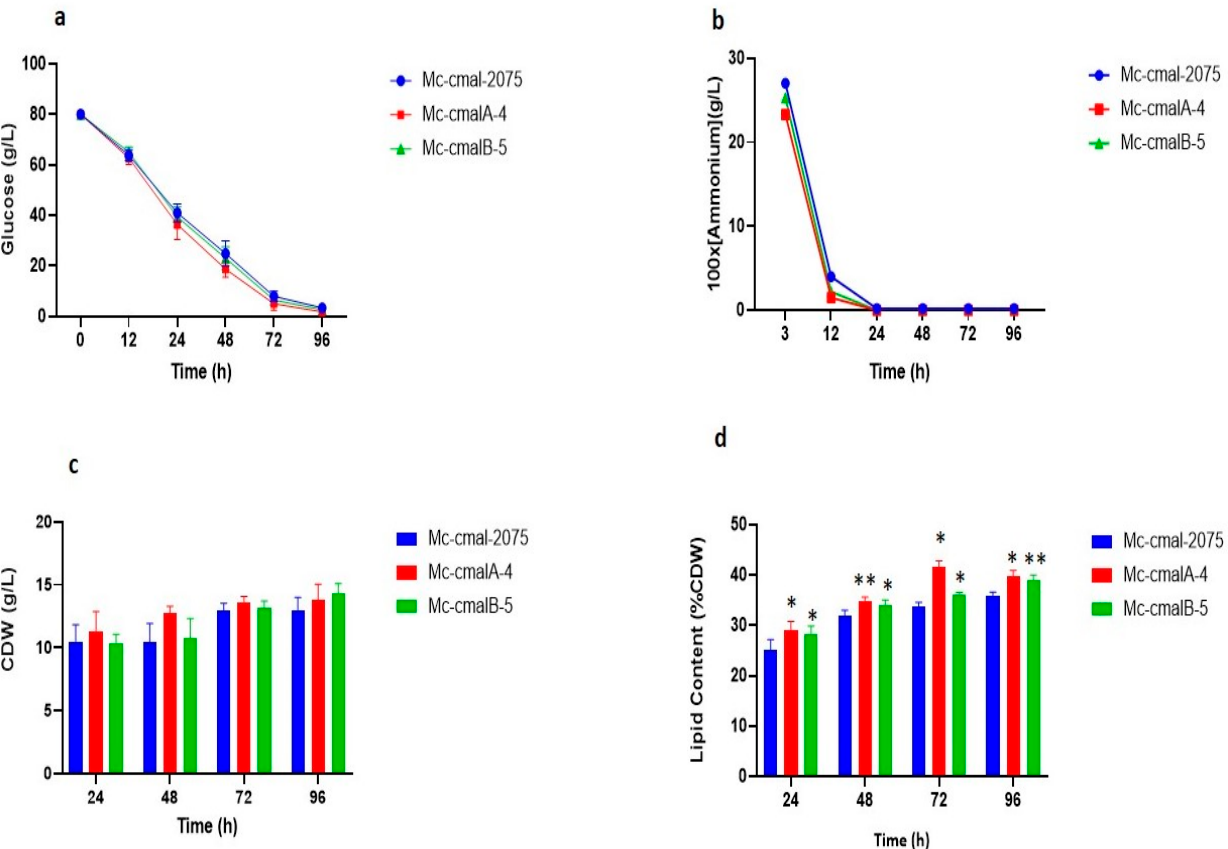
Figure 5. Determination of cell growth of lipid content analysis of recombinant strains (Mc-cmalA-4 and Mc-cmalB-5) and control strain (Mc-cmal-2075) at specific time points. ( a ) Concentration of glucose, ( b ) concentration of ammonium, ( c ) cell dry weight (CDW), ( d ) lipid content. Values are the mean of three biological replicates. Error bars represent the standard error of the mean. Asterisks indicate significant differences: * p < 0.05 and ** p < 0.01. Table 1. Composition of fatty acids (%, w / w of total fatty acids) * in Mc-cmal- 2075, Mc-cmalA-4, and Mc-cmalB-5